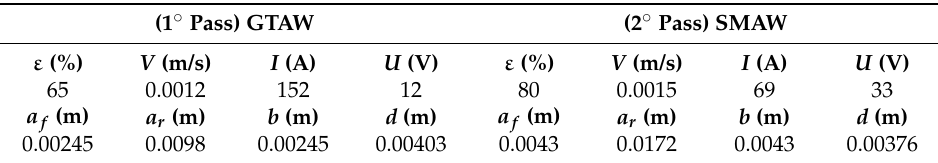
Table 2. Welding parameters used in the simulations.